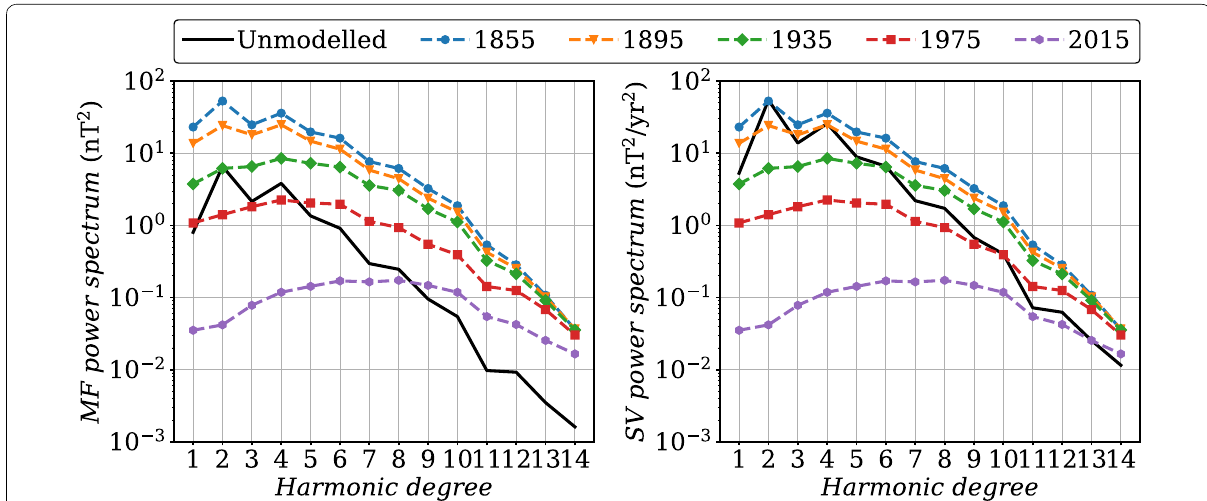
Fig. 6 In black: MF (left) and SV (right) Lowes spectra (Eq. (3)) of our estimate of the unmodeled internal field at high frequencies due to the projection onto splines 2 years apart. It is constructed from the residuals to a spline fit to synthetic AR-2 series (see text for details). In color (dotted lines) are shown the spectra for the COV-OBS.x2 formal posterior uncertainty at epochs 1855, 1895, 1935, 1975, and 2015. These latter are obtained from the ± σ spread within an ensemble of COV-OBS.x2 realizations (i.e., projected onto